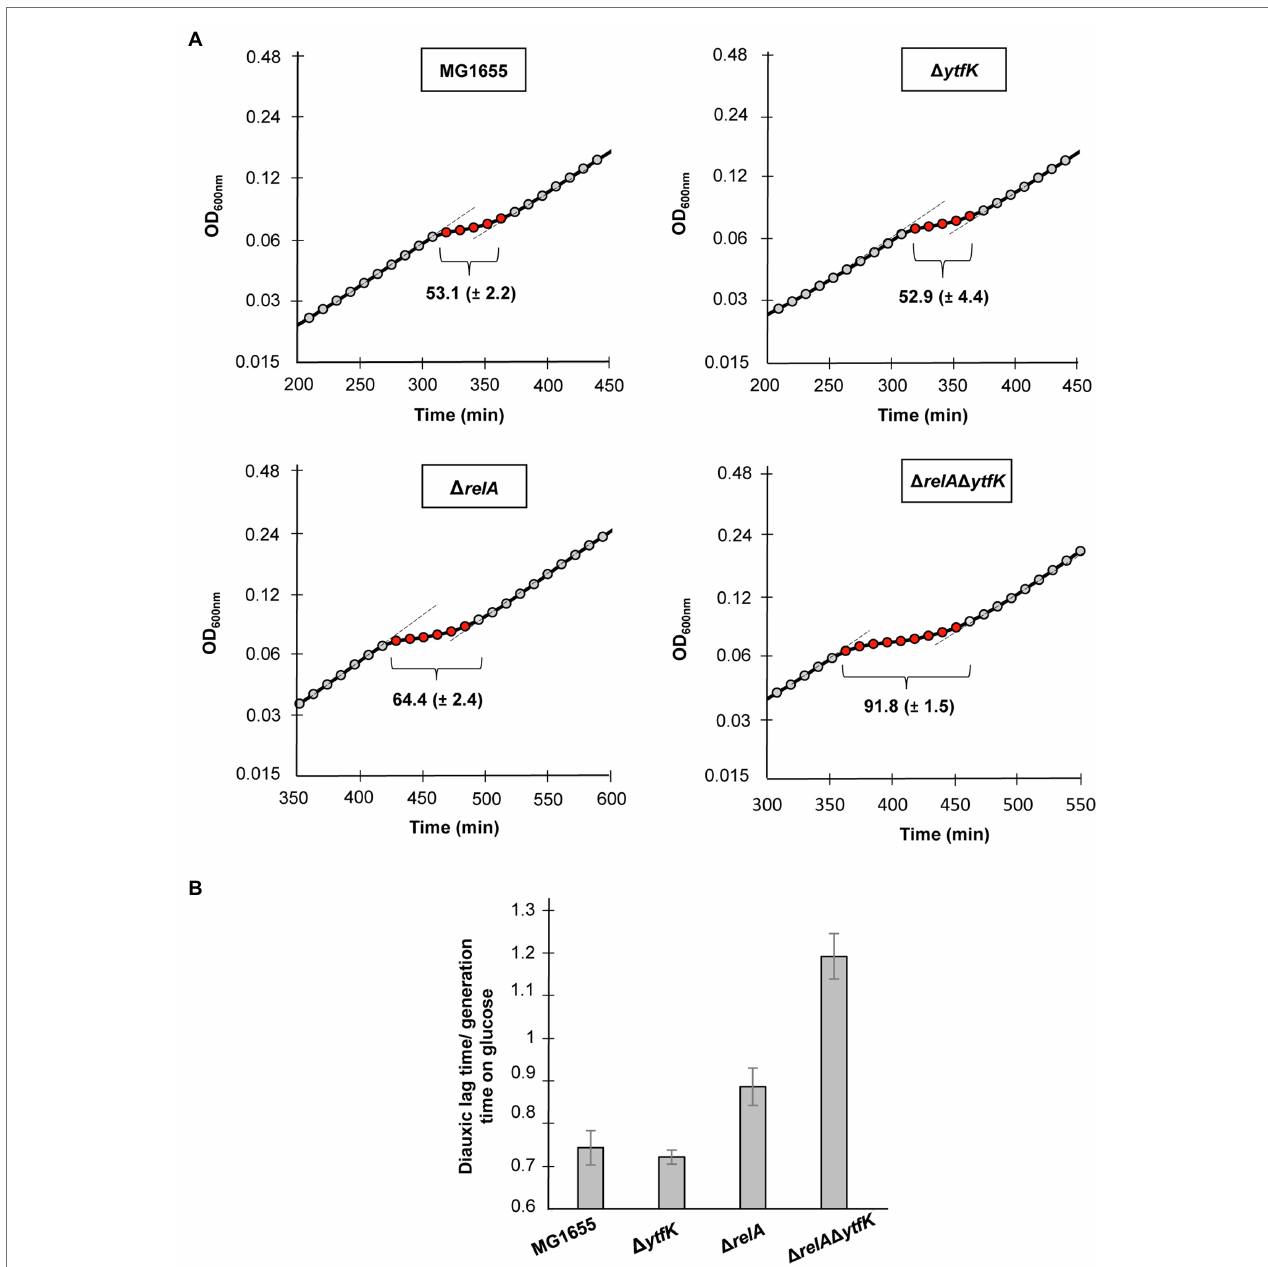
FIGURE 5 | YtfK contributes to diauxic shift adaptation. (A) Cells of MG1655 (WT) and isogenic deletion strains Δ relA , Δ ytfK and the Δ relA Δ ytfK were grown in MOPS minimum medium containing 0.025% of glucose and 0.4% of lactose. Growth was monitored every 10 min using Tecan microplate reader. Representative growth is provided. The length of diauxic lag times (visualized by brackets) is calculated from three independent experiments and was normalized to the generation time during growth on glucose (B) . Error bars indicate the standard deviations of averages of three independent